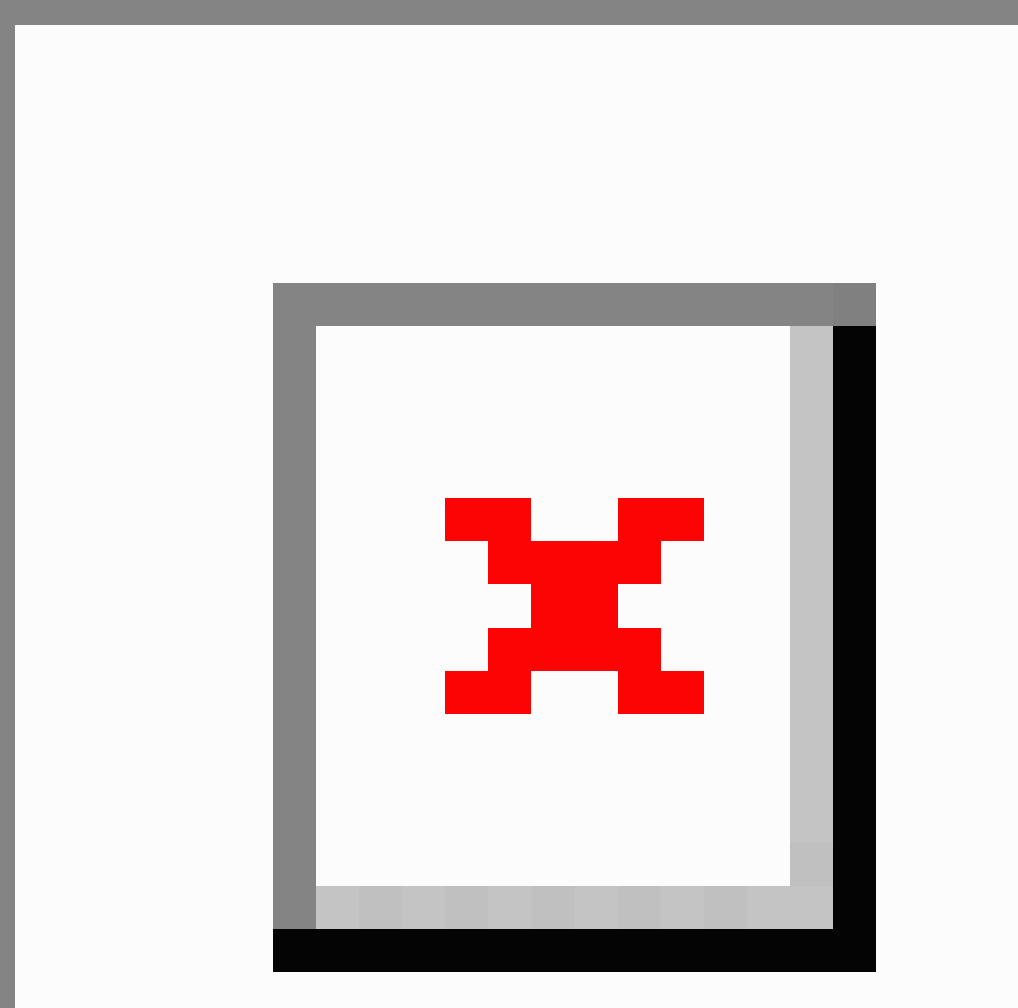
Figure 1. Monthly uploads of electronic cigarette-related videos from January 2007 to December